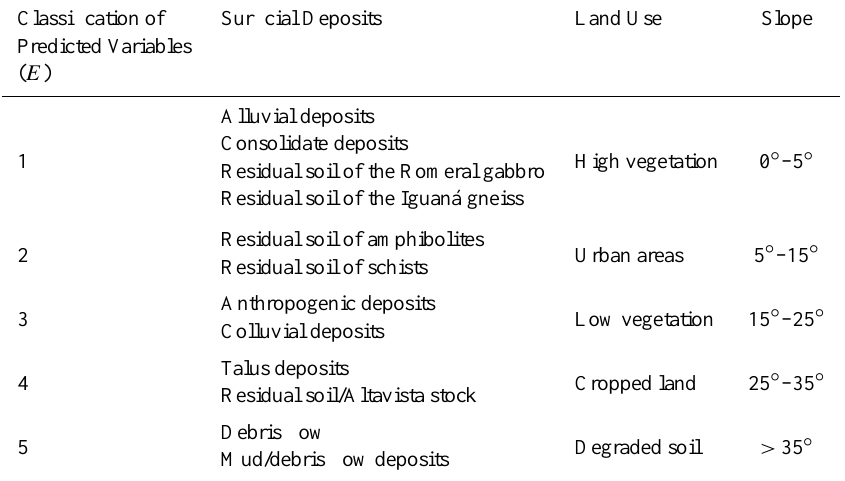
Table 2. Expert classification of predictor factors and their variables ( E ’s in Eq. (1), 1=least susceptible; 5=most susceptible).